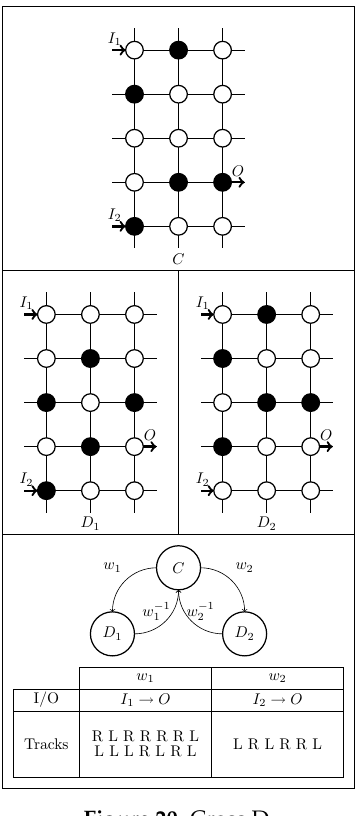
Figure 20. Cross